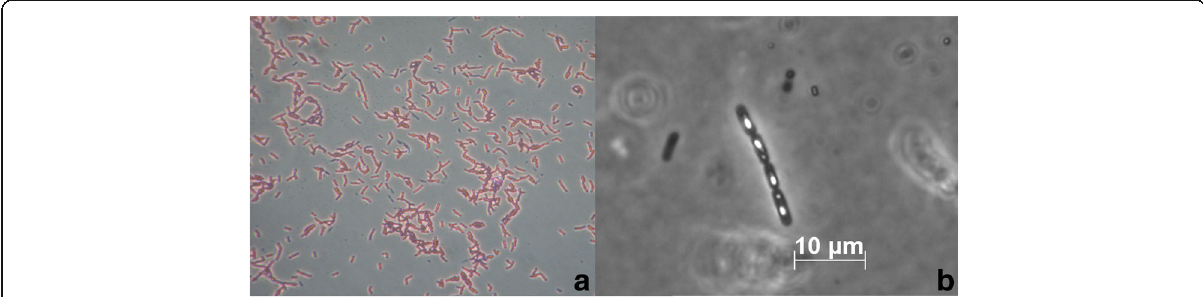
Fig. 1 Microscopic characteristics of Bacillus thuringiensis MYBT18246. a Light microscope analysis of Gram stained B. thuringiensis MYBT18246 cells (40×). b Phase contrast microscope analysis of sporulated and Cry-toxin producing cells of B. thuringiensis MYBT18246